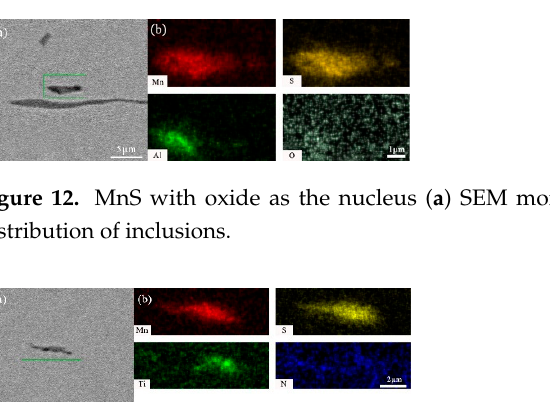
Figure 13. MnS typical diagram associated with TiN precipitation ( a ) SEM morphology of inclusions; ( b ) composition distribution of inclusions.